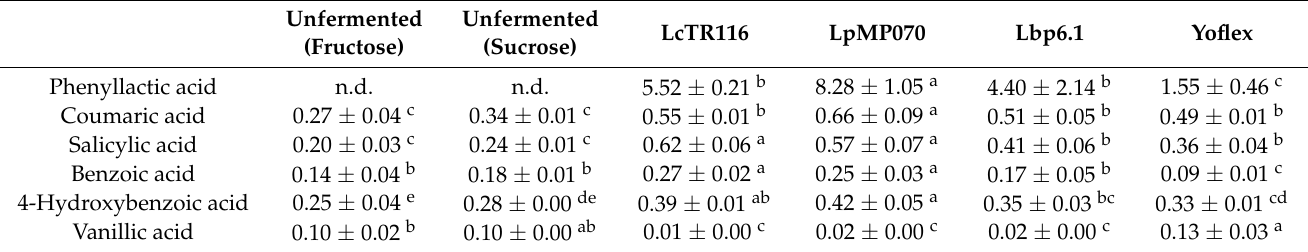
Table 6. Contents of antifungal phenolic compounds as measured by UHPLC-UV in mg/kg. Unfermented Unfermented LcTR116 LpMP070 Lbp6.1 Yoflex (Fructose) (Sucrose) Phenyllactic acid